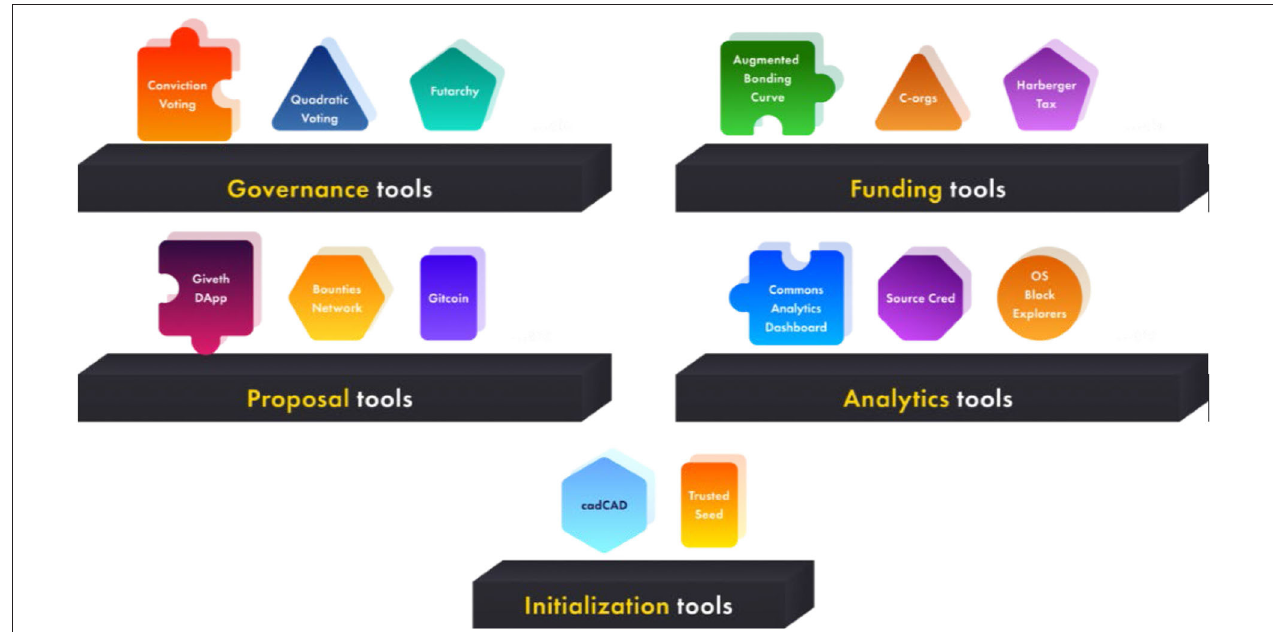
FIGURE 2 | A future stack for the commons (used with permission. Graphic by Jeff Emmet, published in “Architecting the Cyber-Physical Commons”, https:// medium.com/commonsstack/architecting-the-cyber-physical-commons-a294d88b5415).